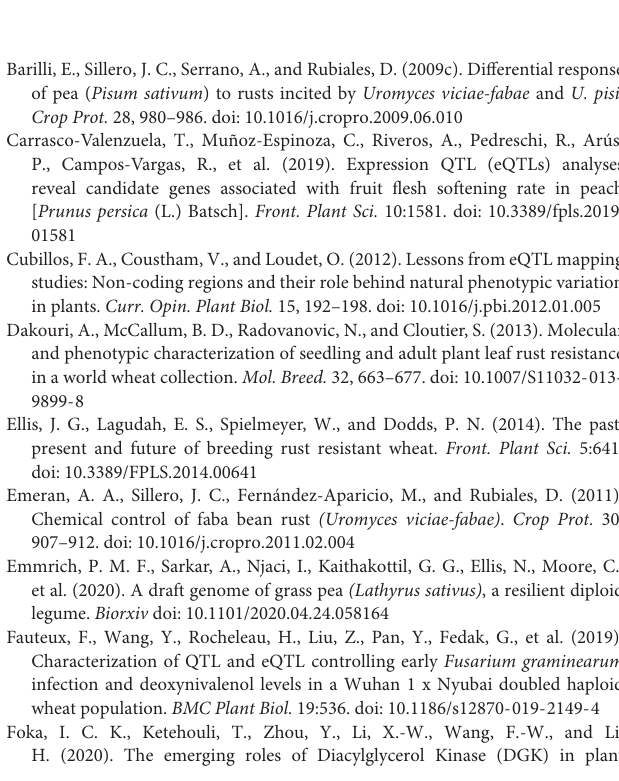
Supplementary Figure 1 | Leaves of Lathyrus cicera inoculated with Uromyces pisi , showing a compatible reaction between plant and pathogen (IT = 4), (A) under controlled conditions (growth chamber) 11 days after inoculation with U. pisi and (B) under semi-controlled field conditions 3 months after inoculation with U. pisi . Supplementary Figure 2 | Expression QTLs syntenic regions of Lathyrus cicera recombinant inbred lines population (BGE023542 × BGE008277) for rust ( Uromyces pisi ) response mapped on the physical map of Pisum sativum . Physical distances given in Mbp are indicated for each P. sativum chromosome. Horizontal pink line indicates the syntenic position of L. cicera differentially expressed gene in P. sativum chromosomes. Black horizontal lines represent the syntenic regions of L. cicera eQTL intervals mapped on P. sativum